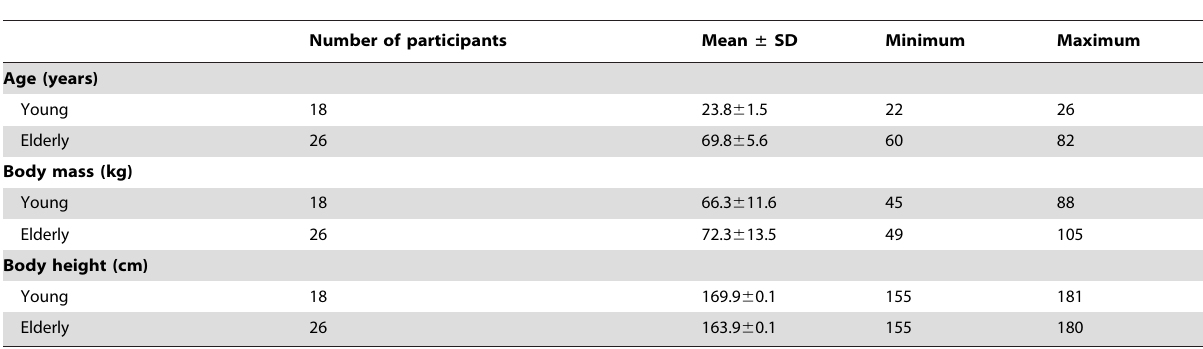
Table 1. Descriptive data for the participants in the